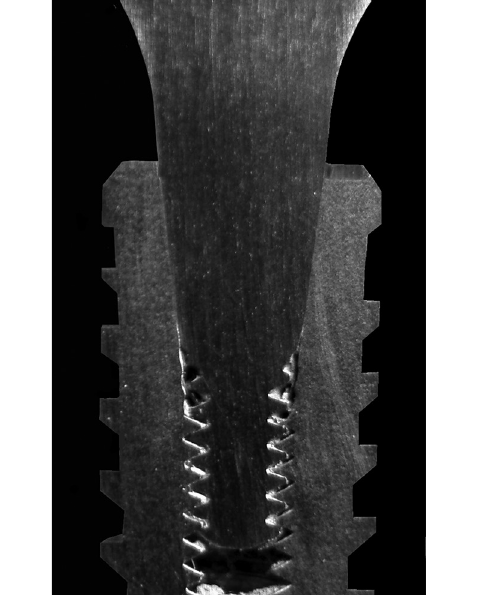
Figure 3. Image of a sample after embedment in resin and central longitudinal section.